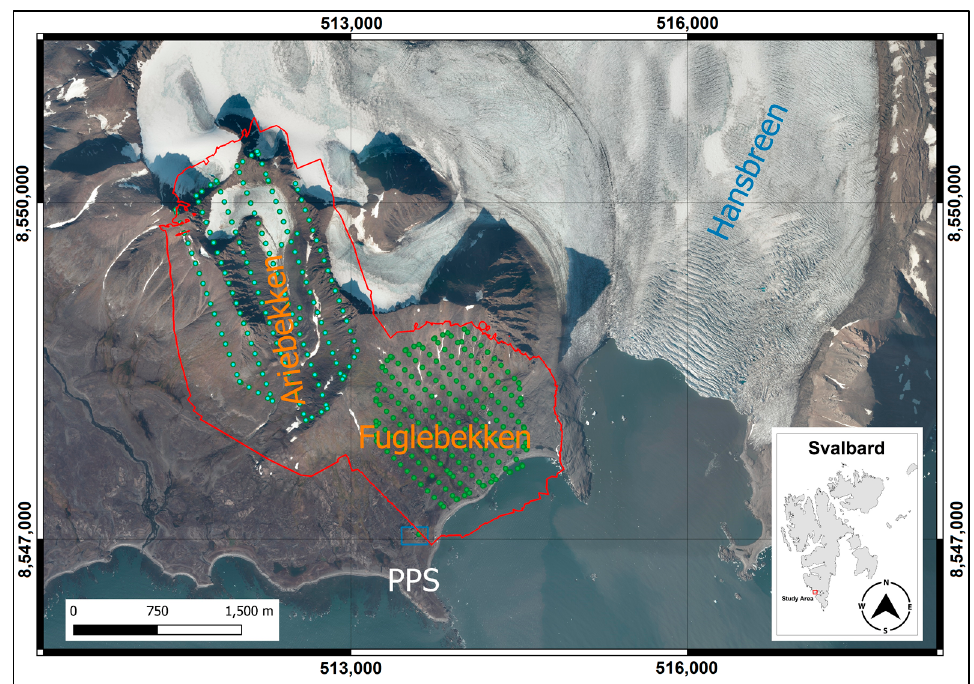
Figure 1. Location of Fuglebekken and Ariebekken catchments. The red polygon denotes the aerial extent of the orthomosaics. The green points correspond to each aerial photograph taken. Image source: toposvalbard.npolar.no.